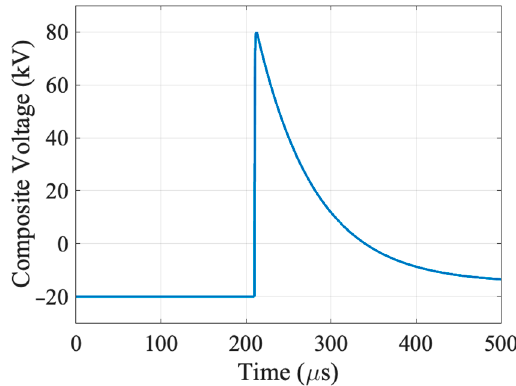
Figure 1. Example composite voltage (CV) waveform by the superimposed 20 kV − DC and 100 kV + LI voltage.